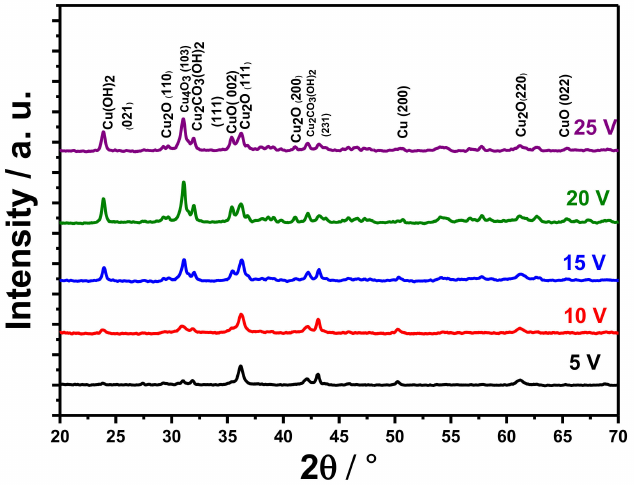
Figure 3. XRD patterns of the anodized copper foam in 0.1 M K 2 CO 3 at 5, 10, 15, 20, 25, and 25